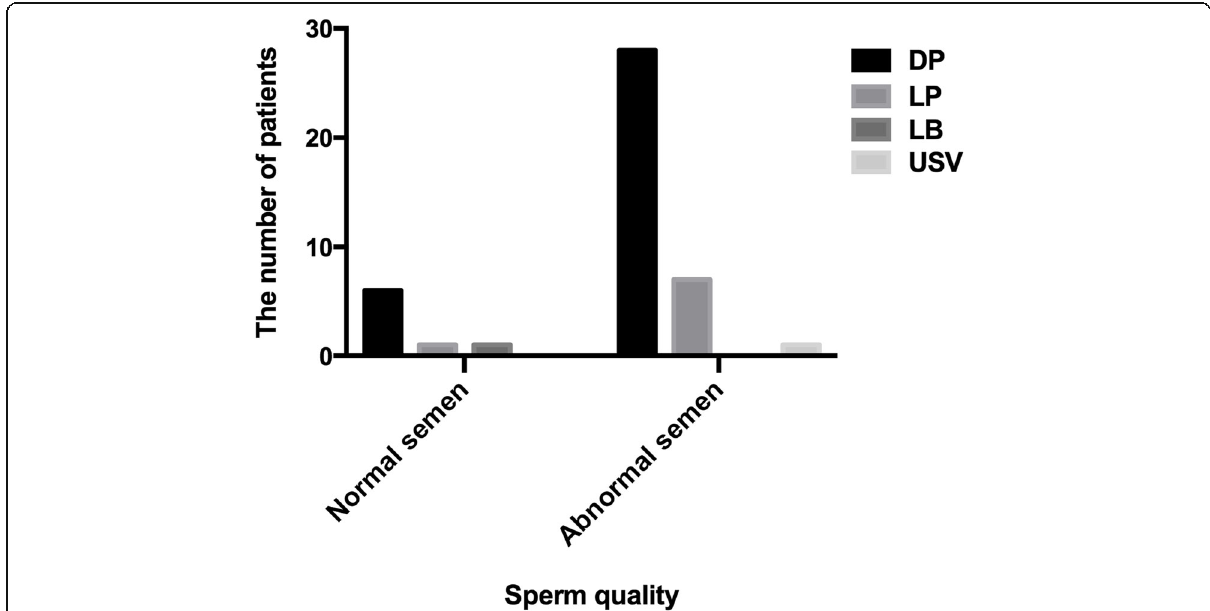
Fig. 1 The semen quality of the male patients who harboured PKD1 mutations. DP, LP, LB and USV are indicated with definitely pathogenic mutations, likely pathogenic variations, likely benign variations and uncertain significance variations, respectively. The results showed that there is no correlation between semen quality and the type of mutation in PKD1